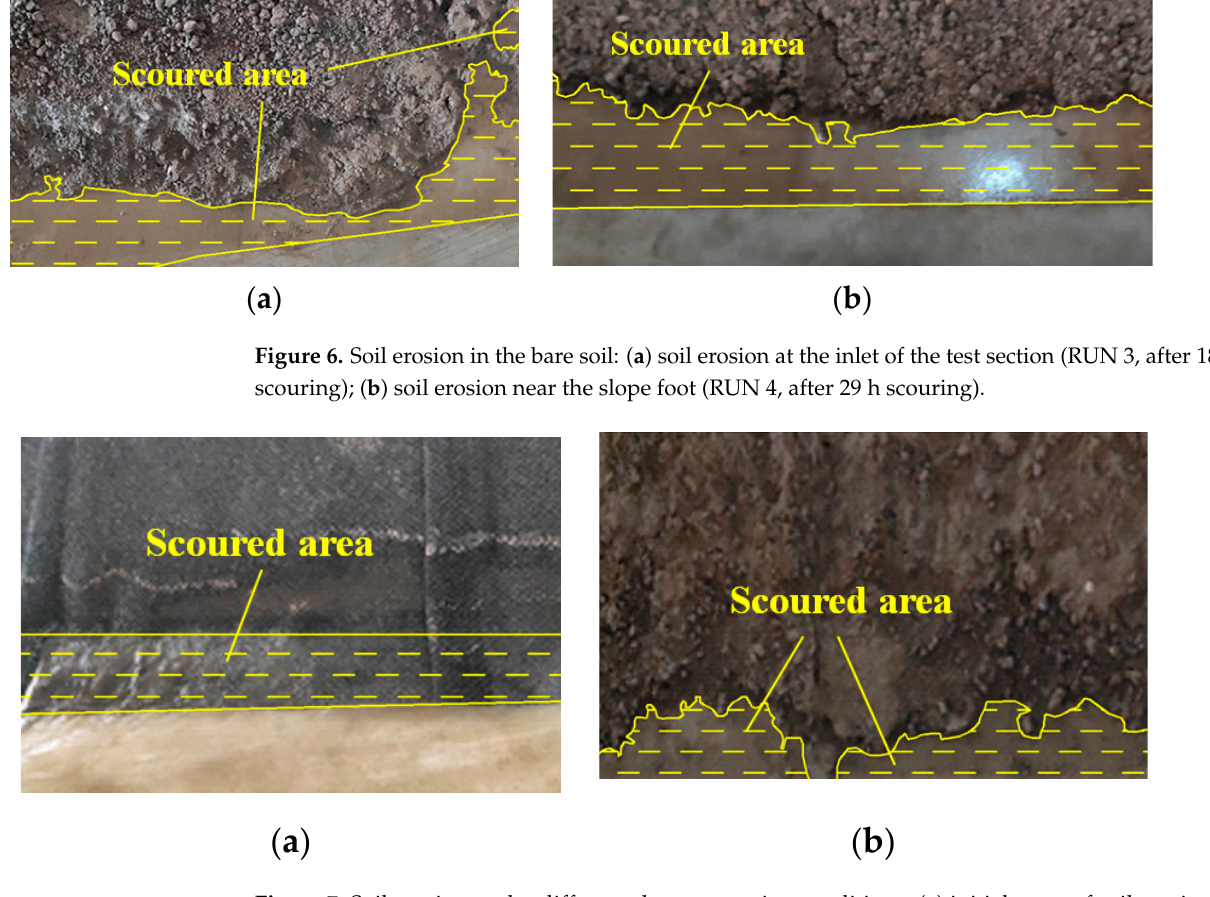
( b ) Figure 8. Damage types of vegetation grass mat material: ( a ) ejection of fixed steel nails (RUN 8, after 2 h scouring); ( b ) material floating (RUN 8, after 2.25 h scouring).